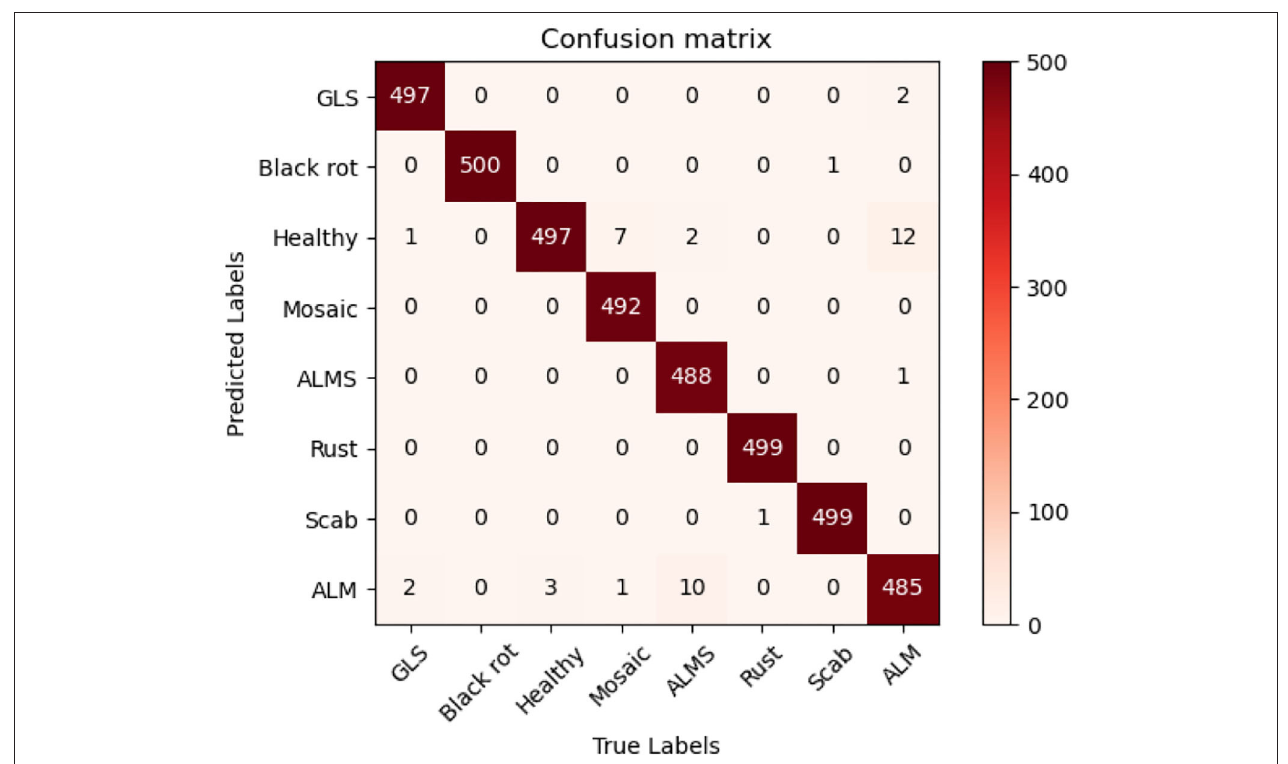
FIGURE 7 | Confusion matrix of the